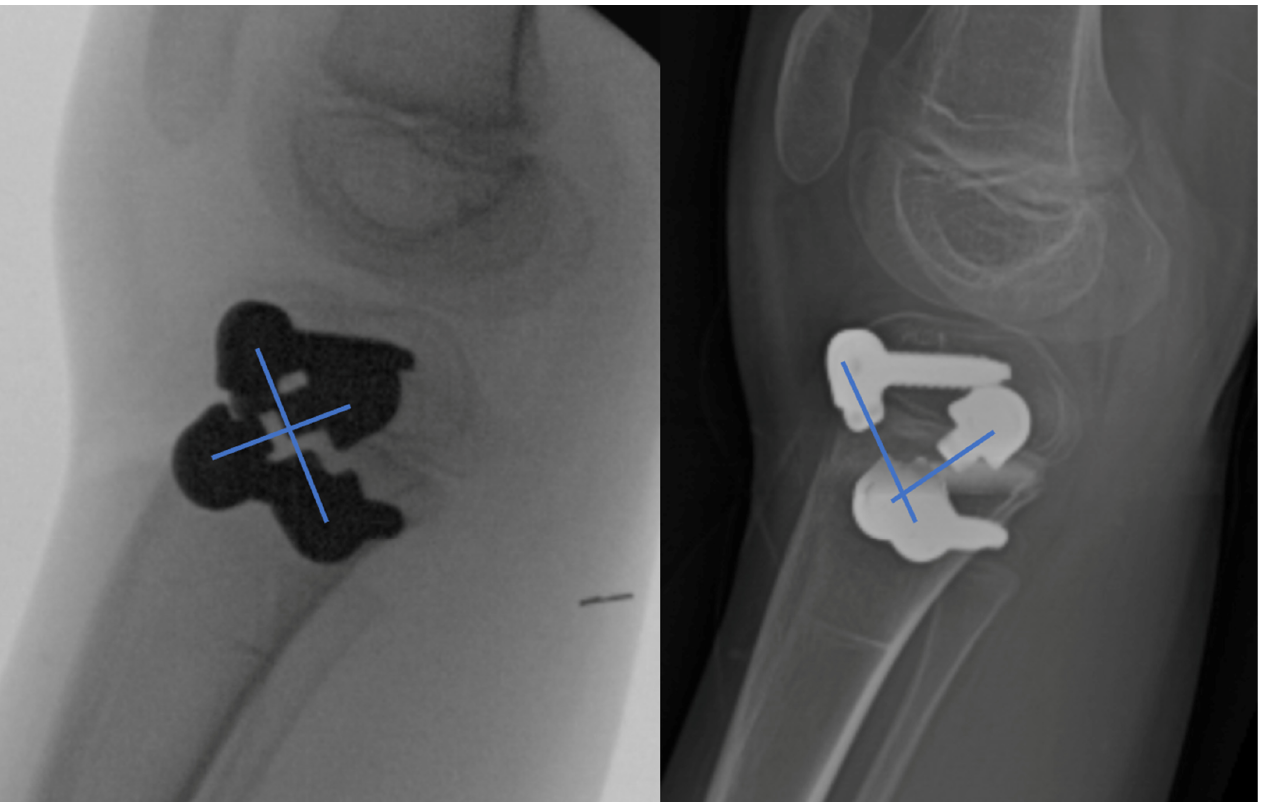
Figure 7. Rotationally guided growth of the tibia (patient #3). Lateral radiographs at the beginning ( left ) and end ( right ) of correction. Note the change in crossing angle. The tibial correction in this case was 17°.